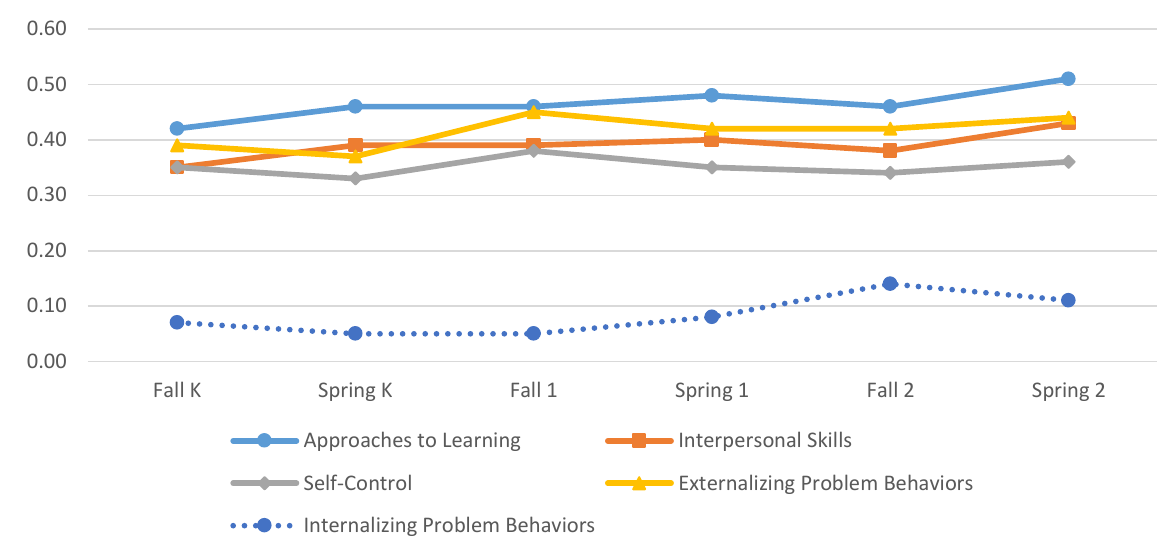
Figure 4: Female Male Gap in Social and Behavioral Skills